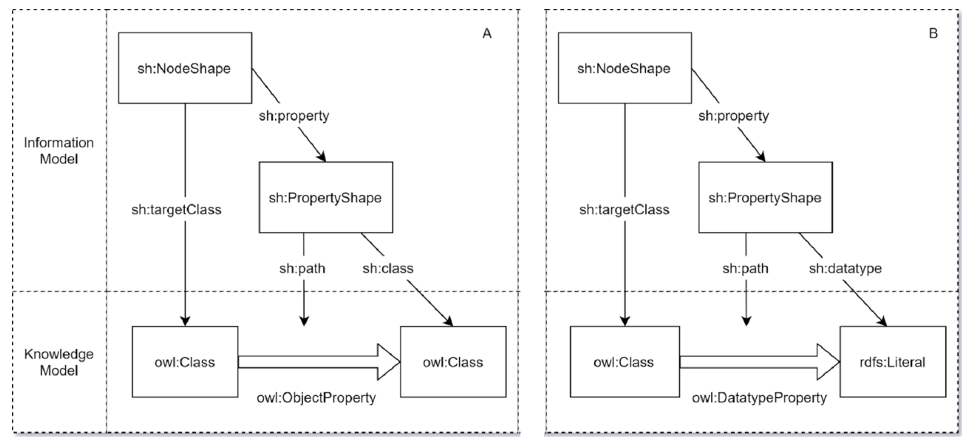
Figure 1. Model mapping of object/datatype properties. Schemes follow another format. ( A ) This